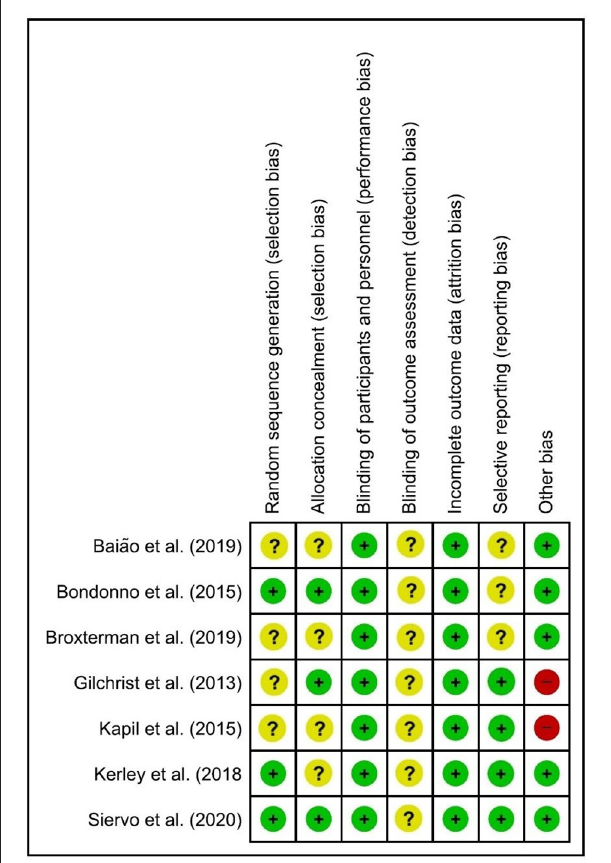
FIGURE 2 | Cochrane risk of bias